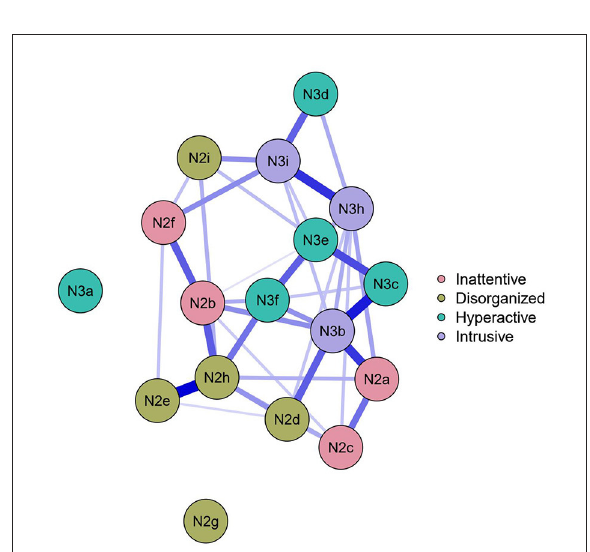
FIGURE2 Regularized networks of the ADHD items colored by facets (before